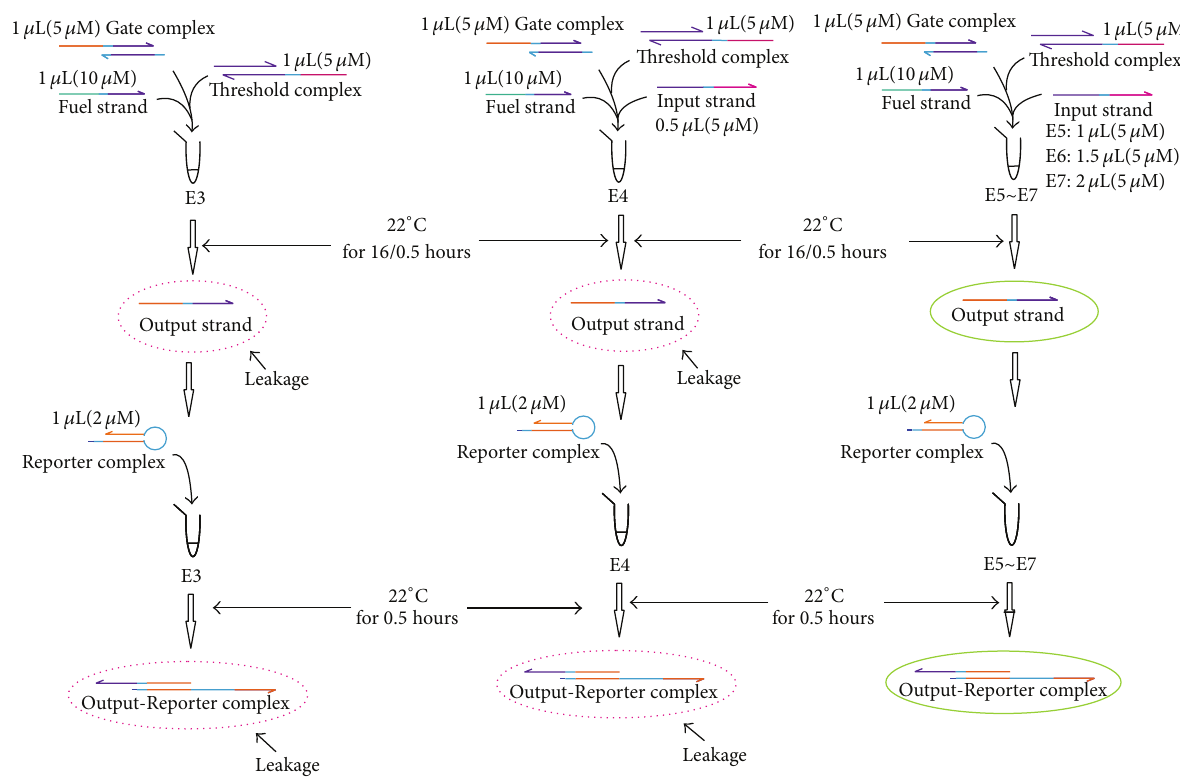
Figure5:Theproceduresofexperimentstoanalyzetheinfluenceofreactiontime(16/0.5hours)toleakyreactionofDNAstranddisplacement with Threshold